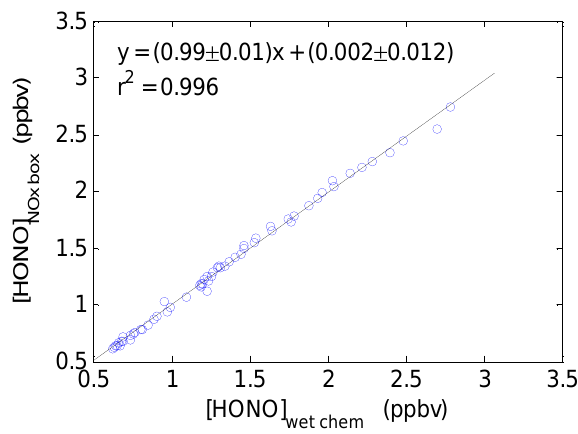
Fig. 2. Comparison of HONO measurements with a wet chemistry- HONO instrument and a TEI NO-NO x analyzer. HONO source was produced by a HONO generation